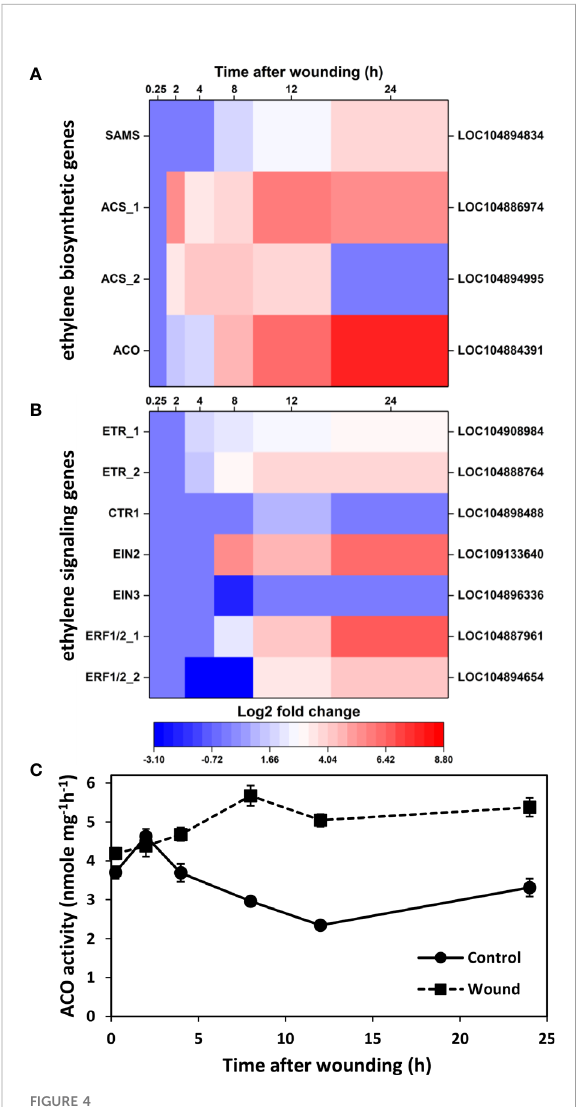
FIGURE 4 Changes in differential expression with respect to time after wounding for genes involved in ethylene biosynthesis (A) and ethylene signaling (B) and enzyme activity of 1- aminocyclopropane-1-carboxylic acid oxidase (AOC) (C) . Heat maps display the log 2 fold change in gene expression between wounded and control roots at 0.25, 2, 4, 8, 12 and 24 h after wounding for all pathway genes that exhibited a log 2 fold change in expression ≥ |1| at any time point. ACO activity was measured as a proxy for ethylene production in wounded and control roots and expressed per mg protein. SAMS, S-adenosyl- L-methionine synthetase; ACS, 1-aminocyclopropane-1- carboxylic acid synthase; ACO, 1-aminocyclopropane-1- carboxylic acid oxidase; ETR, ethylene receptor; CTR1, constitutive triple response 1; EIN, ethylene insensitive; ERF, ethylene response factor. For all analyses, n =4. Error bars are SE of the